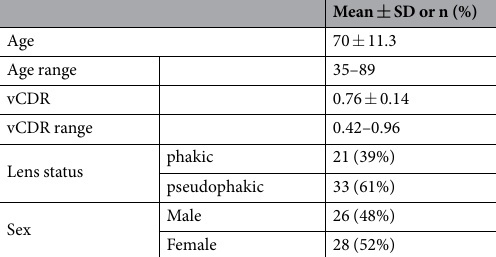
Table 1. Demographics. SD = standard deviation.